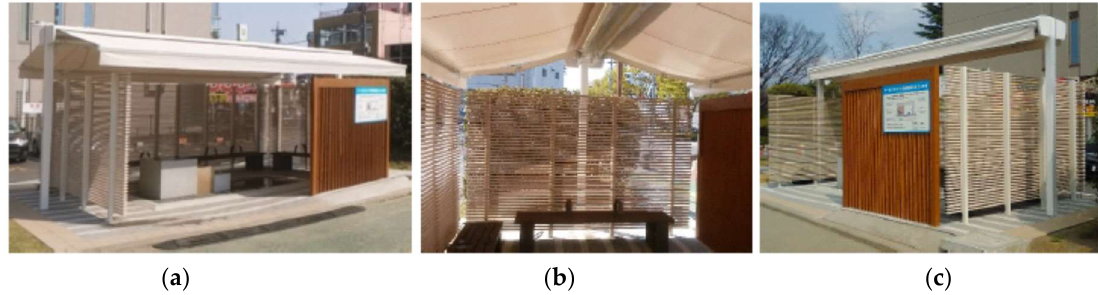
Figure 1. Automatically opening and closing awning installed at a bus stop, which are provided by Prof. Misaka. ( a ) whole view; ( b ) internal view; ( c ) closed state.